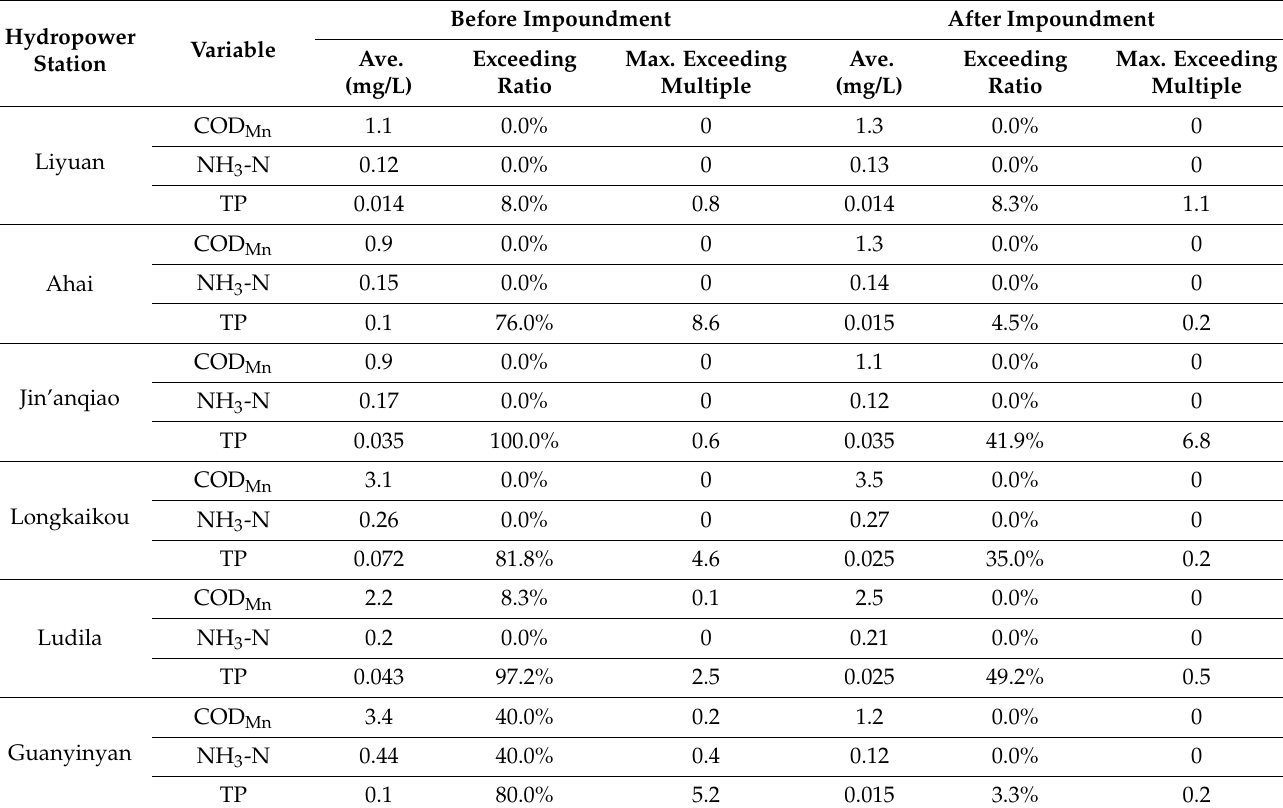
Table 4. Water quality monitoring results before and after water impoundment at hydropower